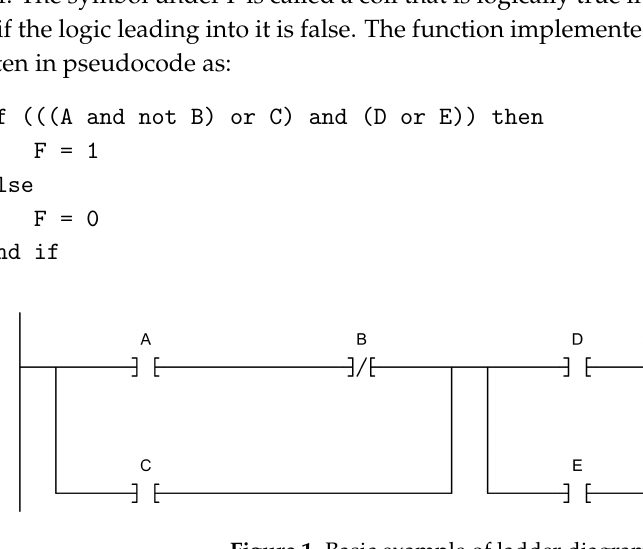
Figure 1. Basic example of ladder diagram